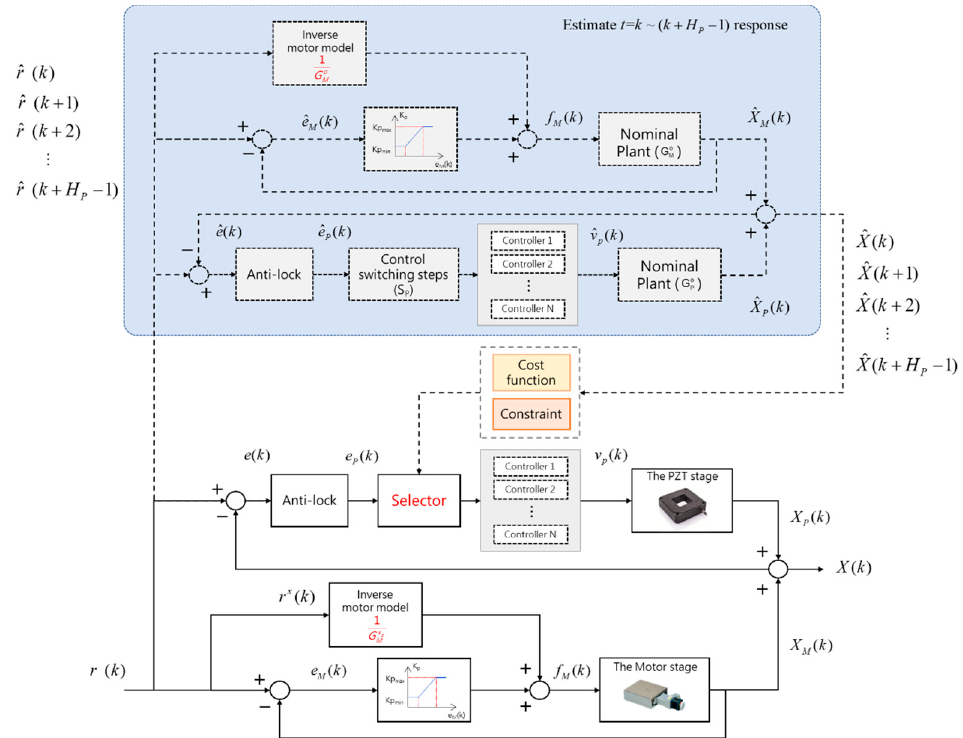
Figure 9. The switching control structure for the combined stage.